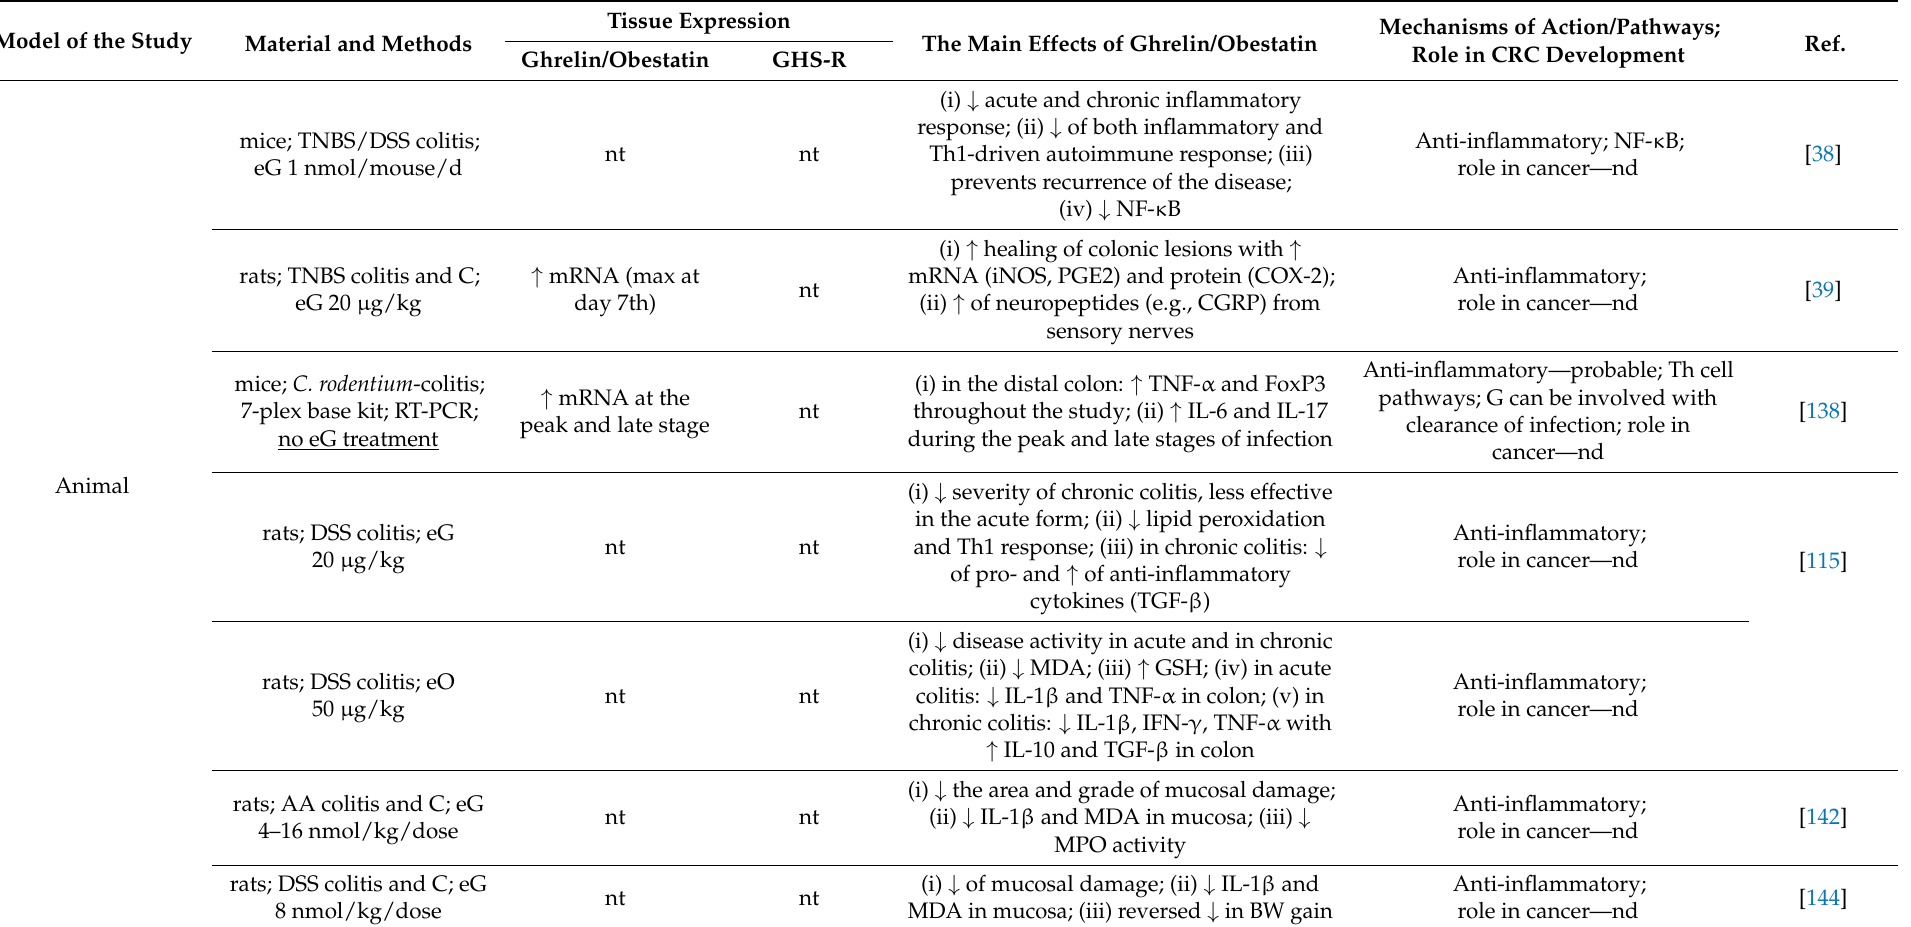
Table 1. The Ghrelin System Components in the Colon Inflammation—Animal and in vitro